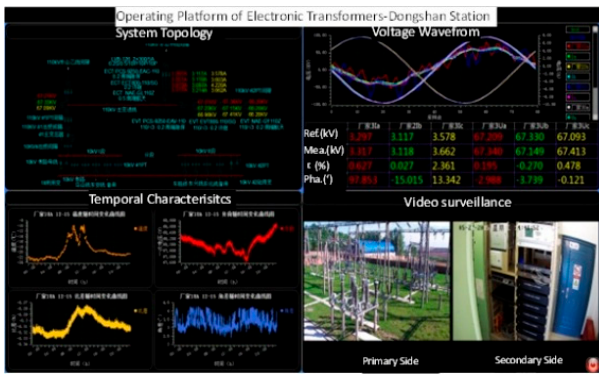
Figure 7. OVT on-line error monitoring system.